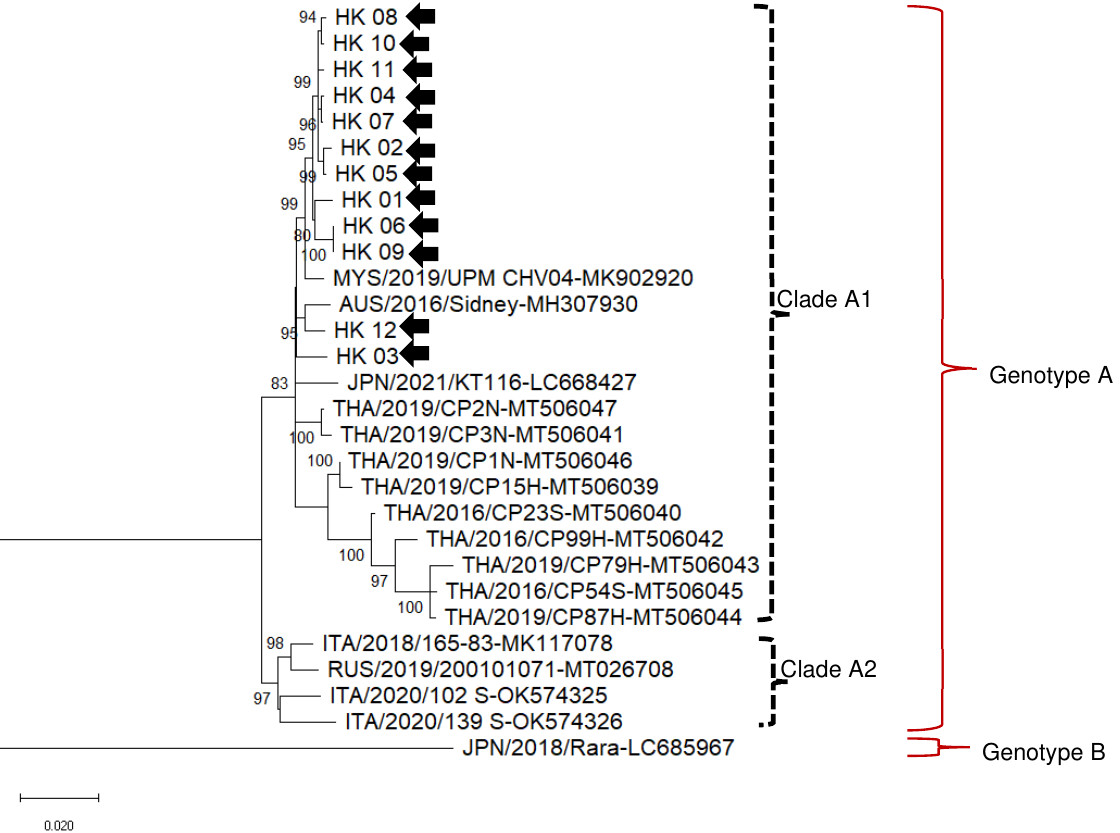
Table 4. Nucleotide identity between domestic cat hepadnavirus (DCH) Genotypes and Clades based on the overall genome.